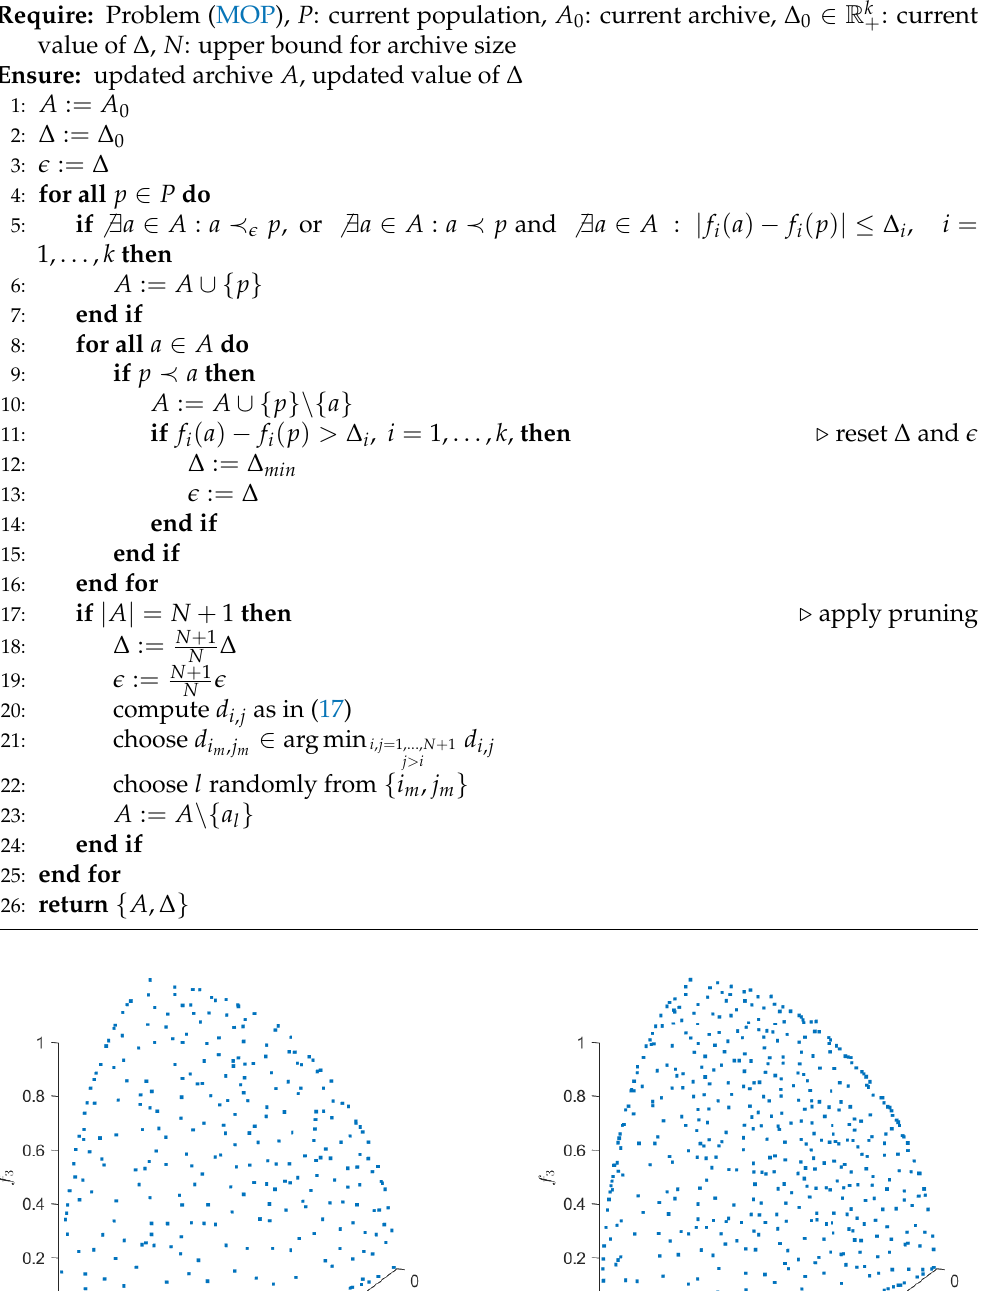
Algorithm 4 { A , ∆ } : = ArchiveUpdateHD ( P , A 0 , ∆ 0 , N )